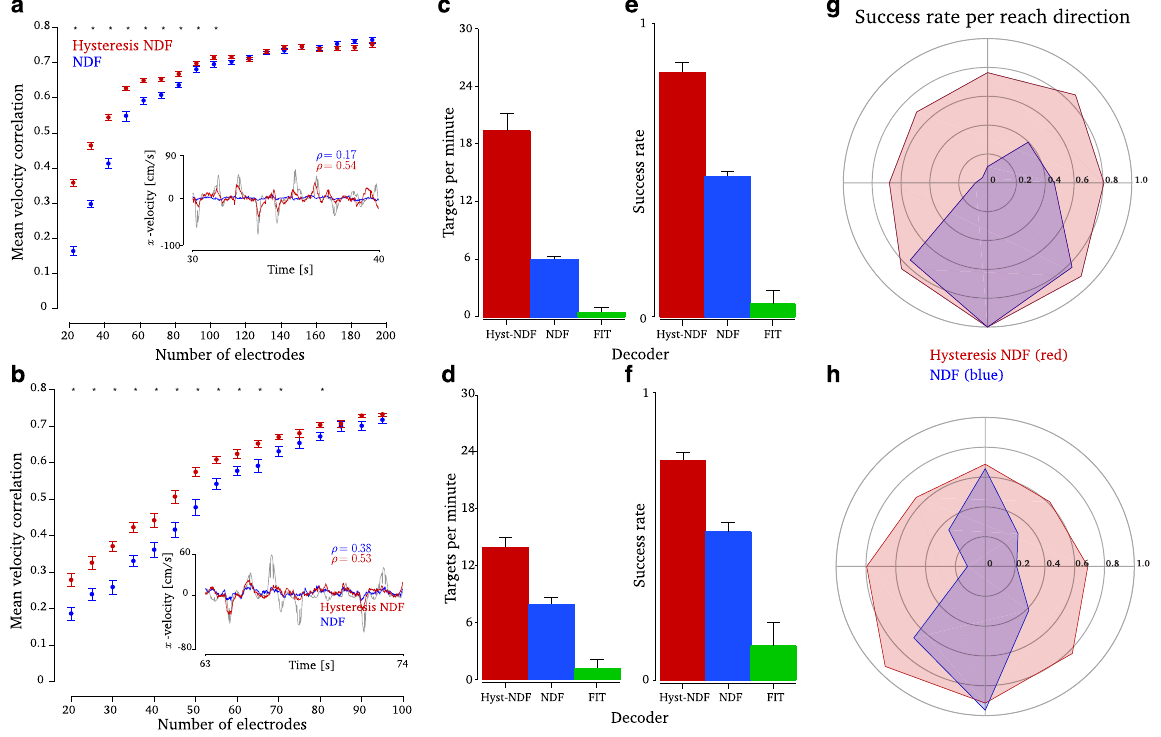
Figure 2. Offline and online evaluation of decoder hysteresis. ( a ) An offline simulation with Monkey J, where electrode loss is simulated and offline decode performance (mean correlation in reconstructing hand velocity) is measured. When 90 or more neural electrodes were lost, the HNDF achieved significantly higher offline decode performance than the NDF (denoted by * p < 0.01, Wilcoxon signed-rank test). The inset shows an example of decoded x -velocity (true hand velocity in gray, NDF decoded velocity in blue, and HNDF decoded velocity in red) when 140 electrodes were lost. In this example, the NDF essentially loses a degree-of-freedom of control, being unable to generate velocities in the x -direction, while the HNDF rescues the BMI by recovering the lost degree-of-freedom. ( b ) Same as ( a ) but for Monkey L. When 40 or more neural electrodes were lost, the HNDF achieved significantly higher offline decode performance than the NDF ( p < 0.01, Wilcoxon signed-rank test). The inset shows an example of decoded x -velocity when 50 electrodes were lost. ( c ) The performance of the HNDF, NDF, and FIT-KF in closed-loop experiments for Monkey J, with the simulated loss of 110 electrodes. The HNDF performs significantly better (19.4 radial targets per minute) than the NDF (6.0 radial targets per minute) and FIT-KF, which was uncontrollable on 19 out of 20 sessions. Datasets J_2015-05-18, J_2015-05- 19, J_2015-05-20, J_2015-05-21 comprising 3,642 NDF trials and 3,903 HNDF trials. ( d ) Same as ( c ) but for Monkey L, with the simulated loss of 60 electrodes. The HNDF performs significantly better (13.9 radial targets per minute) than the NDF (8.0 radial targets per minute) and the FIT-KF, which was uncontrollable on 14 out of 16 sessions. Datasets L_2015-05-28, L_2015-05-29, L_2015-06-02, L_2015-06-03, L_2015-06-04 comprising 4,568 NDF trials and 4,646 HNDF trials. ( e ) Success rate of radial target acquisition for Monkey J. The HNDF acquired targets at far higher success rates (83%) than the NDF (48%). ( f ) Same as ( e ) but for Monkey L. The HNDF acquired targets at far higher success rates (76%) than the NDF (52%). ( g ) Target success rate to each center-out target in the workspace averaged over all sessions for Monkey J. There was a deficiency in the NDF to the upper and left parts of the workspace. ( h ) Same as ( g ) but for the Monkey L. There was a deficiency in the NDF along the x